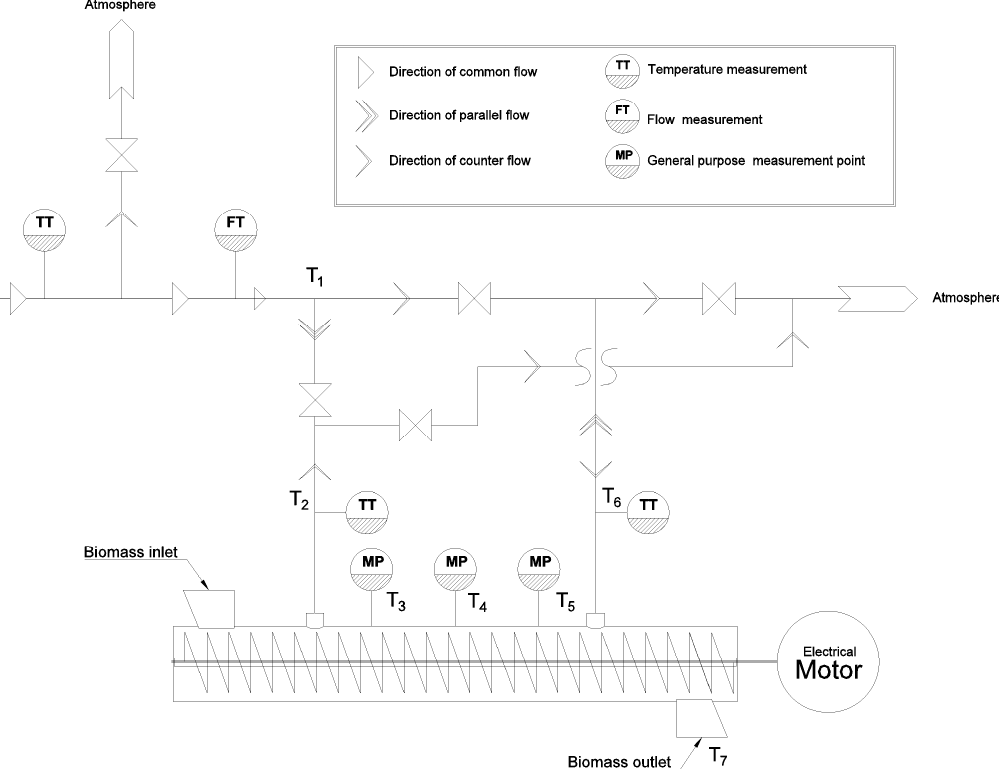
Figure 2. Schematic of an experimental setup. T 1 : temperature of hot air; T 2 : temperature of a hot gas chimney; T 3 : temperature of a dryer gas inlet; T 4 : temperature of first measurement point; T 5 : temperature of second measurement point; T 6 : temperature of a dryer gas outlet; and T 7 : temperature of an olive pomace outlet.